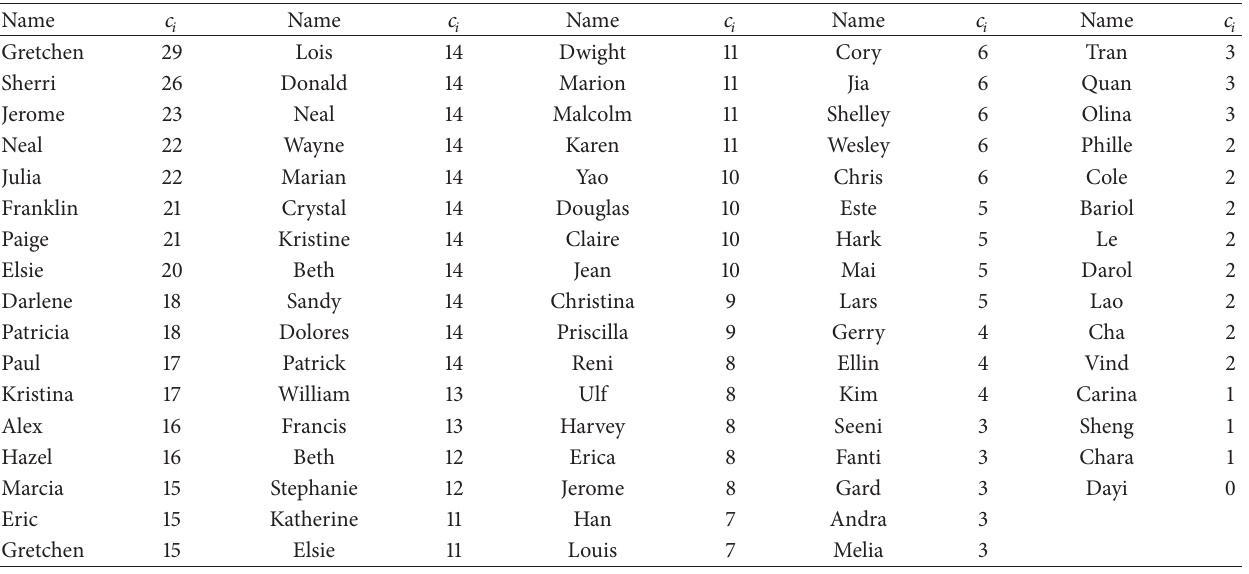
Table 1: Point centrality.